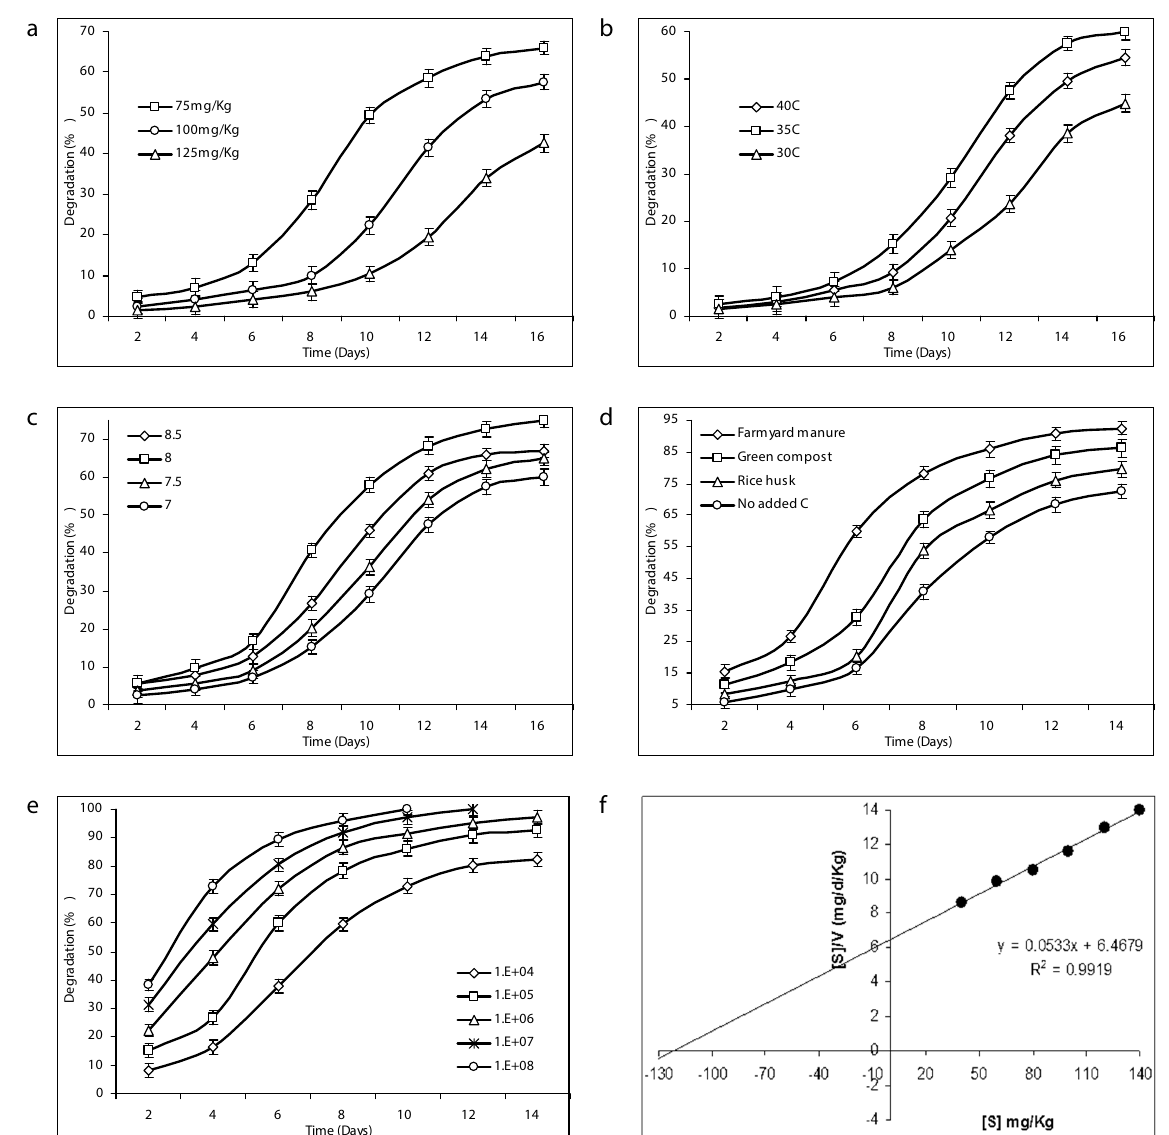
Figure 2. Biodegradation rate of CP at different factors in laboratory soil. ( a ) pH: 7, inoculum density: 10 5 (CFU mL −1 ), incubation temperature: 37 °C and C-source: nil. ( b ) CP conc: 100 mg kg −1 , pH: 7, inoculum density: 10 5 (CFU g −1 ) and C-source: nil. ( c ) CP Conc: 100 mg kg −1 , inoculum density: 10 5 (CFU g −1 ),